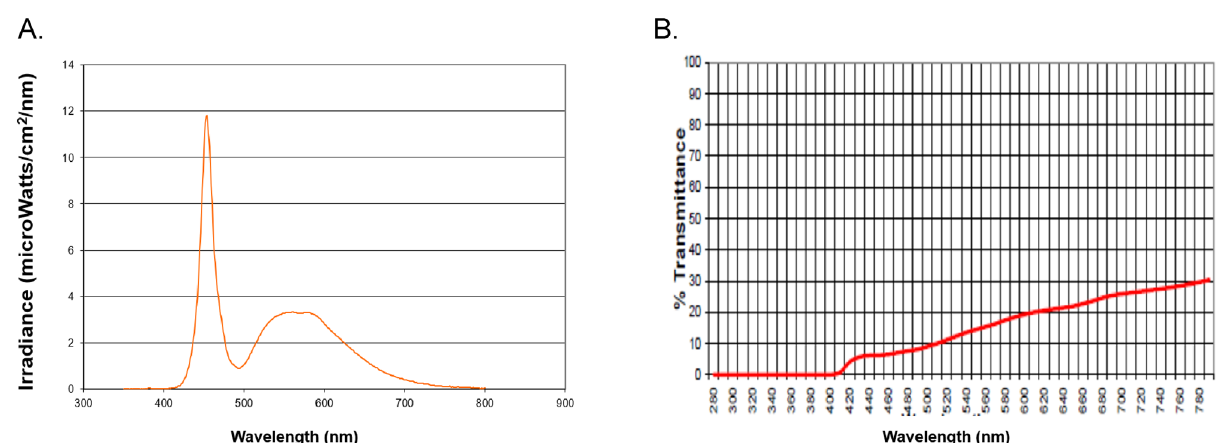
Figure 2. The spectral energy distributions of light emitted by the blue enriched white light treatment device ( A ) and the percentage of light transmitted through blue-attenuating glasses ( B